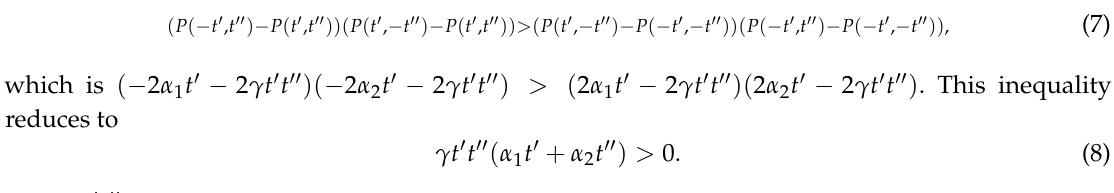
α 1 , − α 2 > γ . Consequently, γ < 0, γ t (cid:48) t (cid:48)(cid:48) > 0 and | γ | > | α 1 | , | α 2 | ; these are inequalities b and c